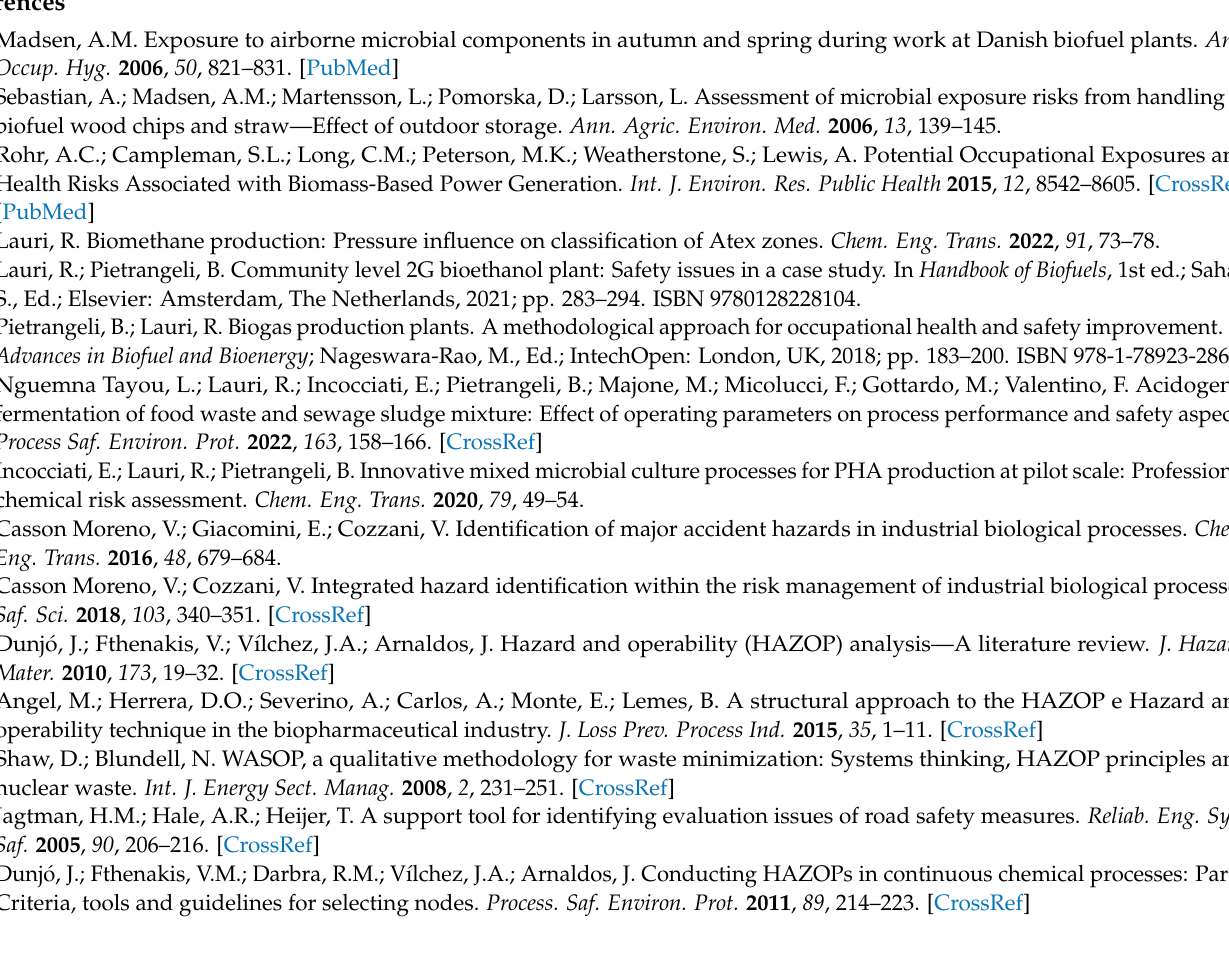
zop study, Table S2: Worksheet obtained by BioHazOp analysis of node 1, Figure S1: P&ID of node 1 (hydrolysis reactor and CSTR) and Figure S2: Final P&ID of node